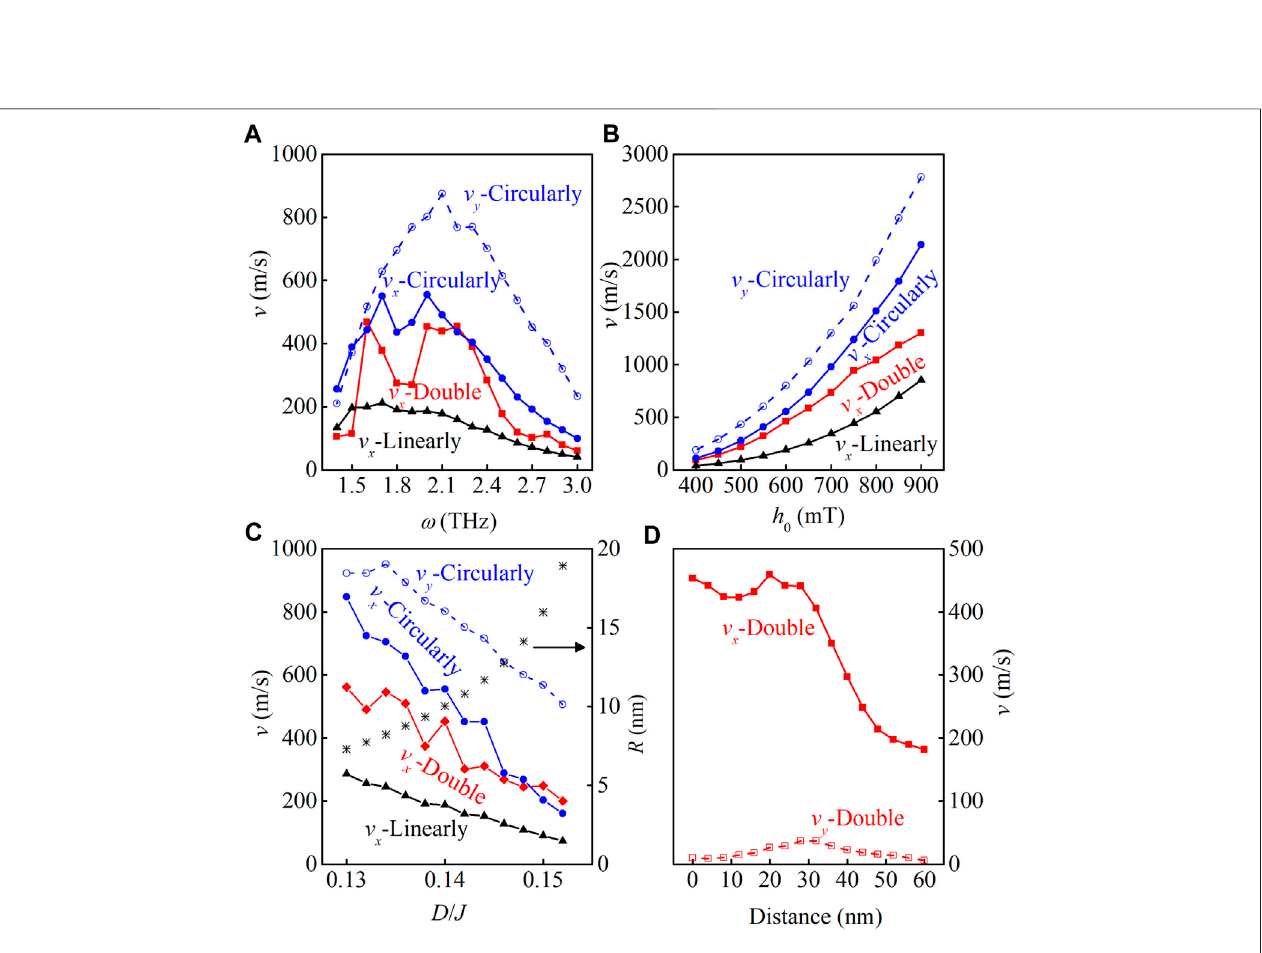
Frontiers in Physics |